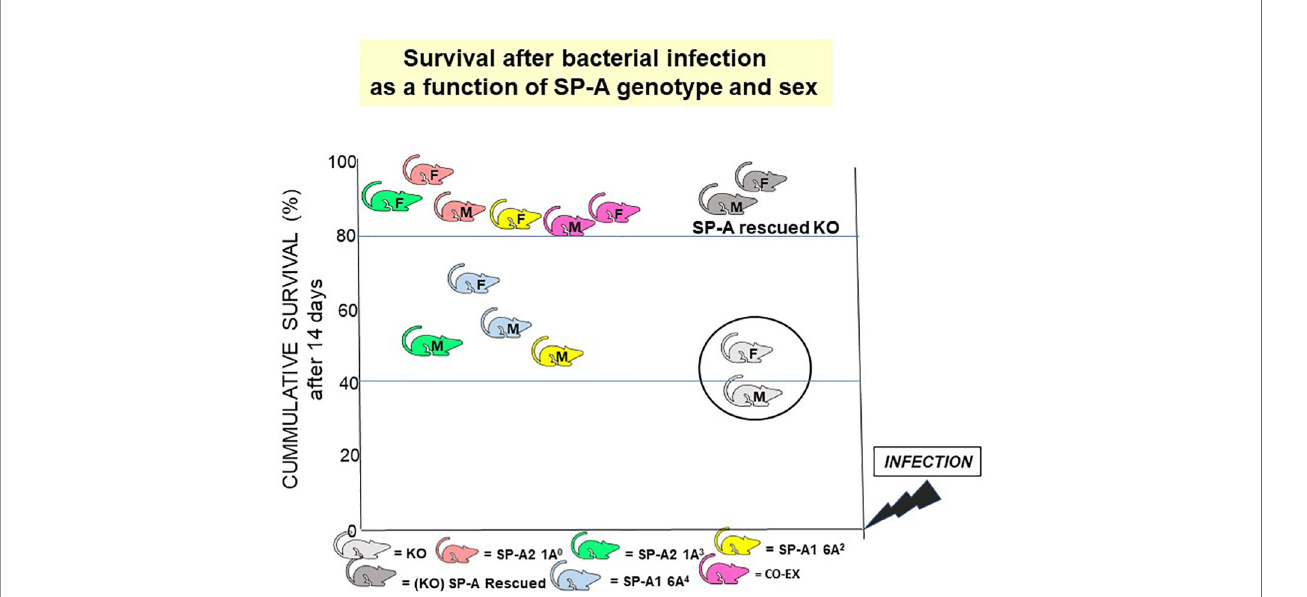
FIGURE 12 | SP-A genotype- and sex-dependent survival after bacterial infection. This cartoon shows that: a) in the absence of SP-A i.e., KO, survival after Klebsiella pneumoniae infection is poor but survival is signi fi cantly improved if the KO mice are rescued with SP-A; and b) survival differs as a function of SP-A genotype and sex (118). However, in the absence of infection, no signi fi cant differences have been observed in mice expressing different variants or in SP-A KO mice, if the mice are housed in a pathogen-free